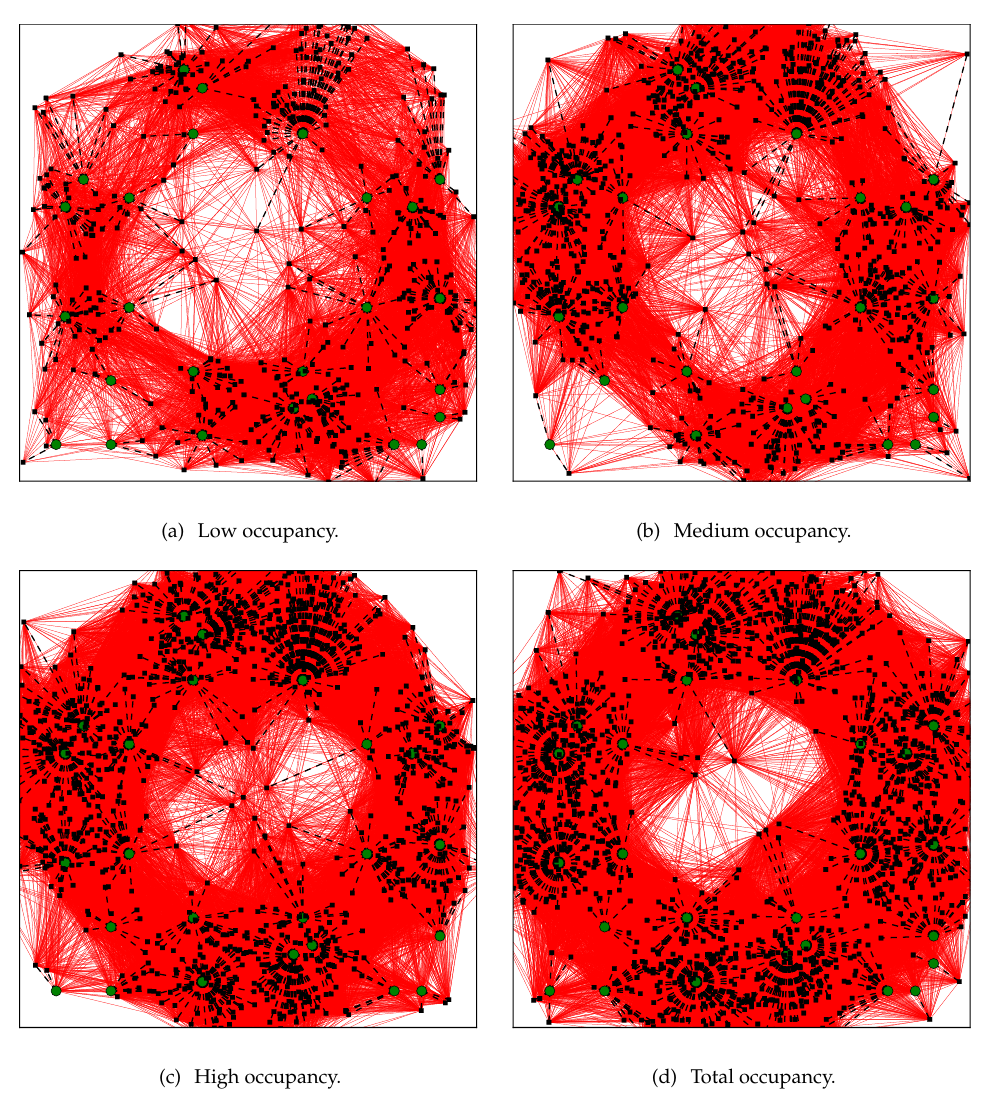
Figure 5. Graph representation of the scenario under study for different classroom